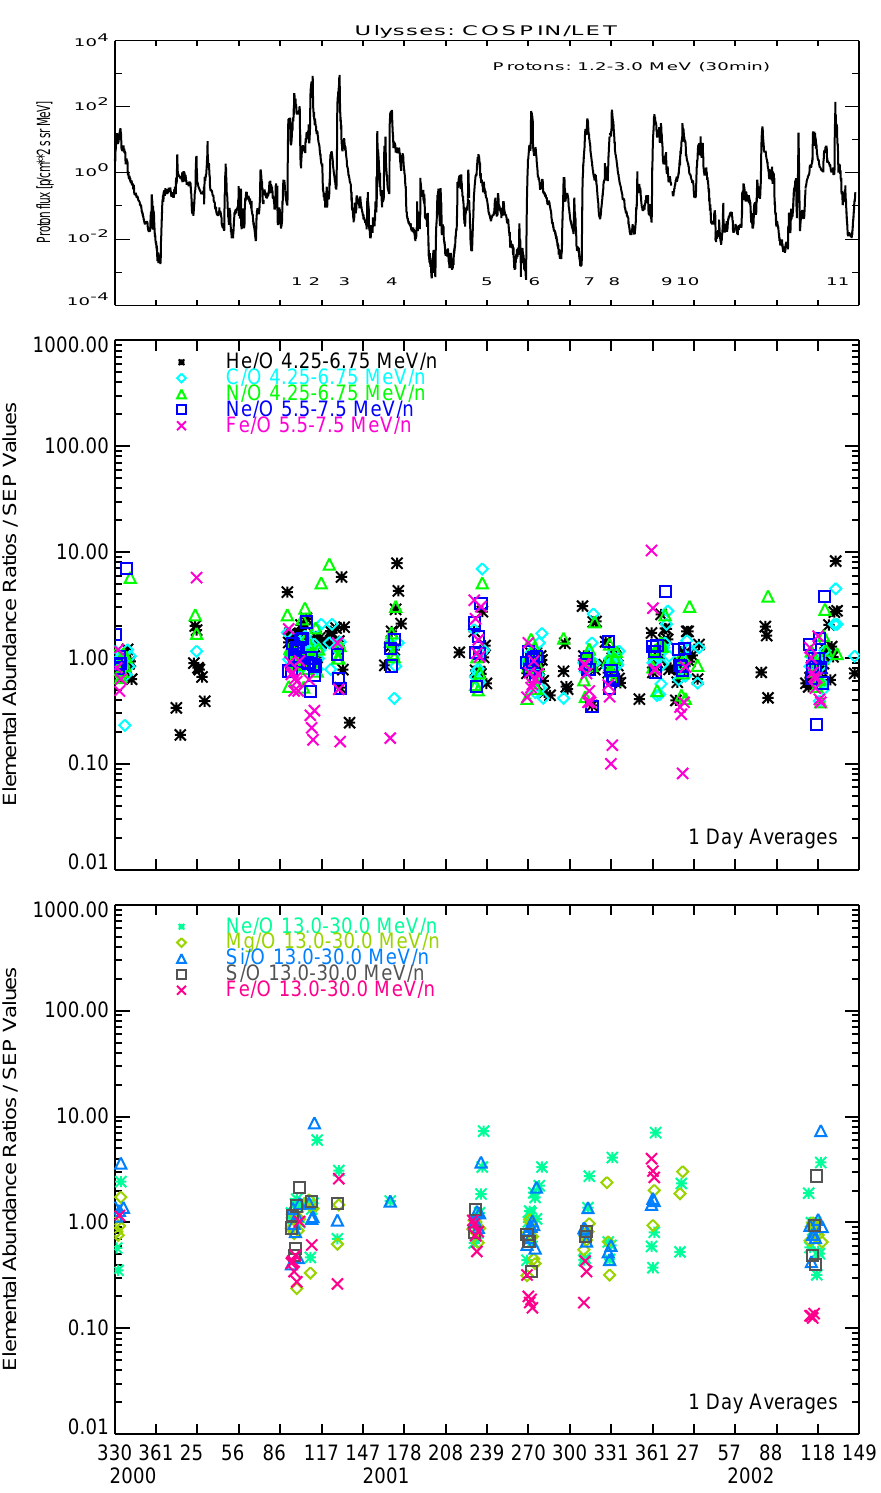
Fig. 3. The 30-min averaged proton flux, and the daily averaged elemental abundance ratios in the lower and the higher energy range from November (DOY 330) 2000 to May (DOY 149) 2002 divided by the corresponding reference SEP values (Mason and Sanderson, 1999) as recorded by the Ulysses COSPIN/LET instrument. In the upper panel the 30-min averaged proton intensity profile (1.2–3.0 MeV) is plotted using a solid line. The selected events are labeled from 1 to 11. The elemental abundance ratios in the energy ranges (4 . 25 to 7 . 5 MeV/n) and (13 to 30 MeV/n) are shown in the middle and the lower